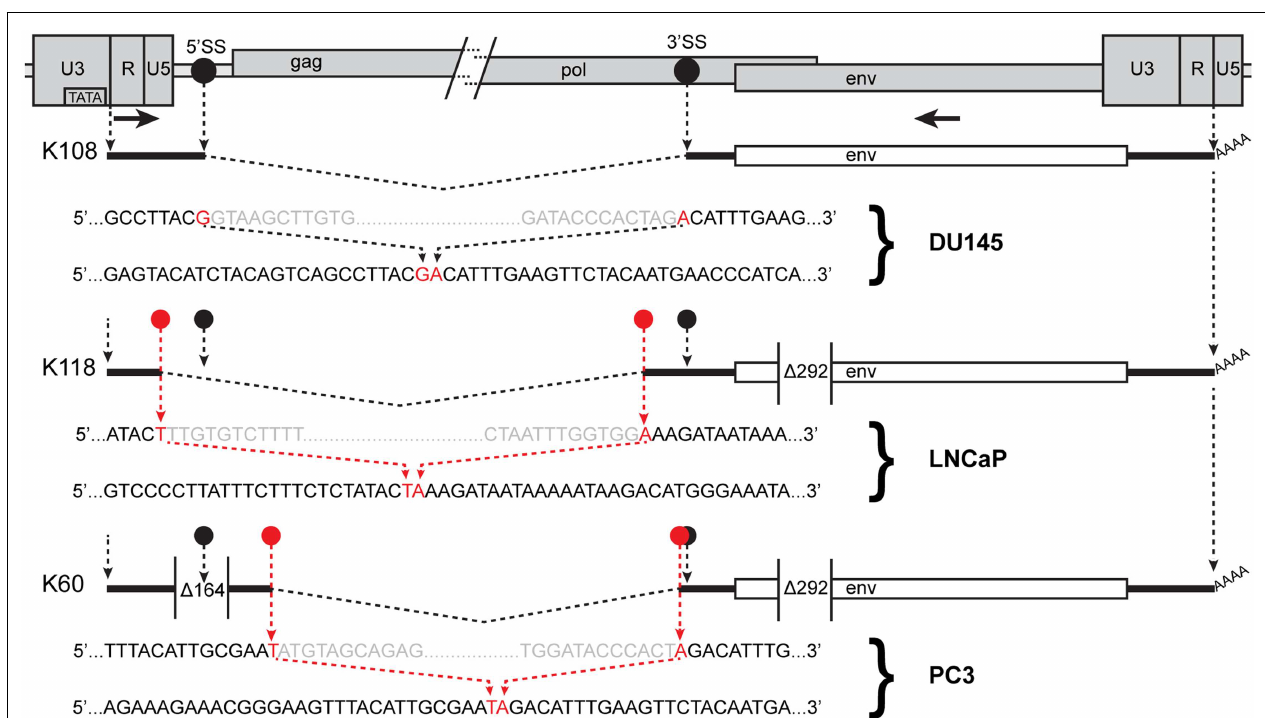
of the sequences where unconventional splicing occurred. For each spliced product, the top sequence shows the inferred primary transcript sequence determined from that of the cognate genomic locus, and the bottom sequence shows the sequence of the RT-PCR product. Red nucleotides were joined in the spliced product. Gray nucleotides show the ends of the excised sequences.The positions of the 292-nt deletion definitive of type I proviruses and a 164-nt deletion in the K60 provirus relative to other HERV-K proviruses are